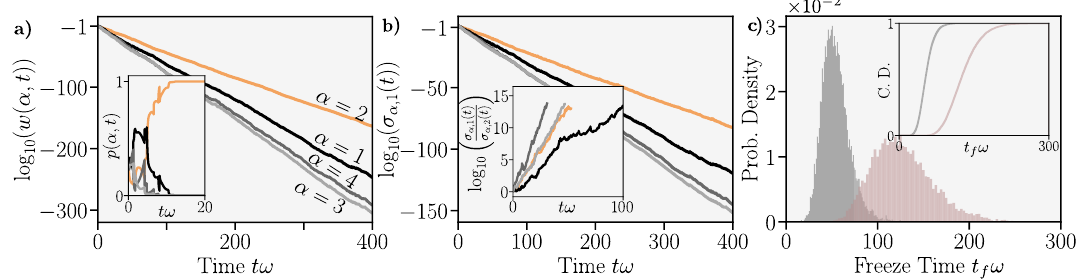
Figure 2: Freezing for a ‘random’ Liouvillian constructed from a random block- diagonal Hamiltonian H and a single random block-diagonal jump operator L